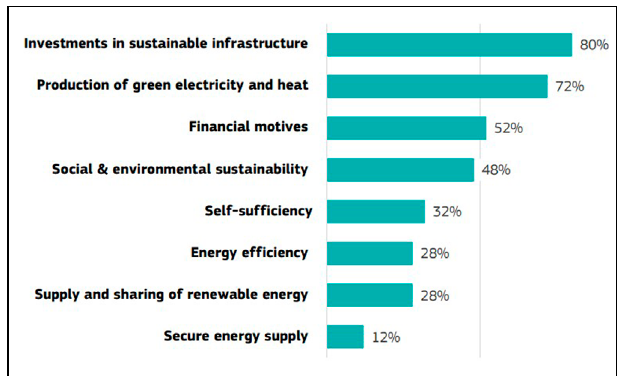
FIGURE 1 | Drivers motivating participation in energy communities (24 case studies) (Caramizaru and Uihlein, 2019).